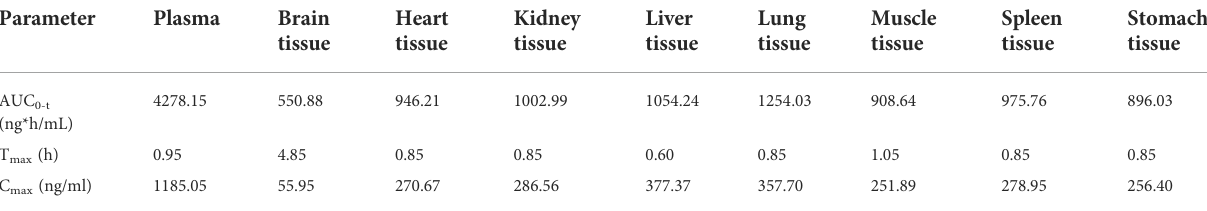
TABLE 6 Pharmacokinetic parameters of 50 mg PTU in each